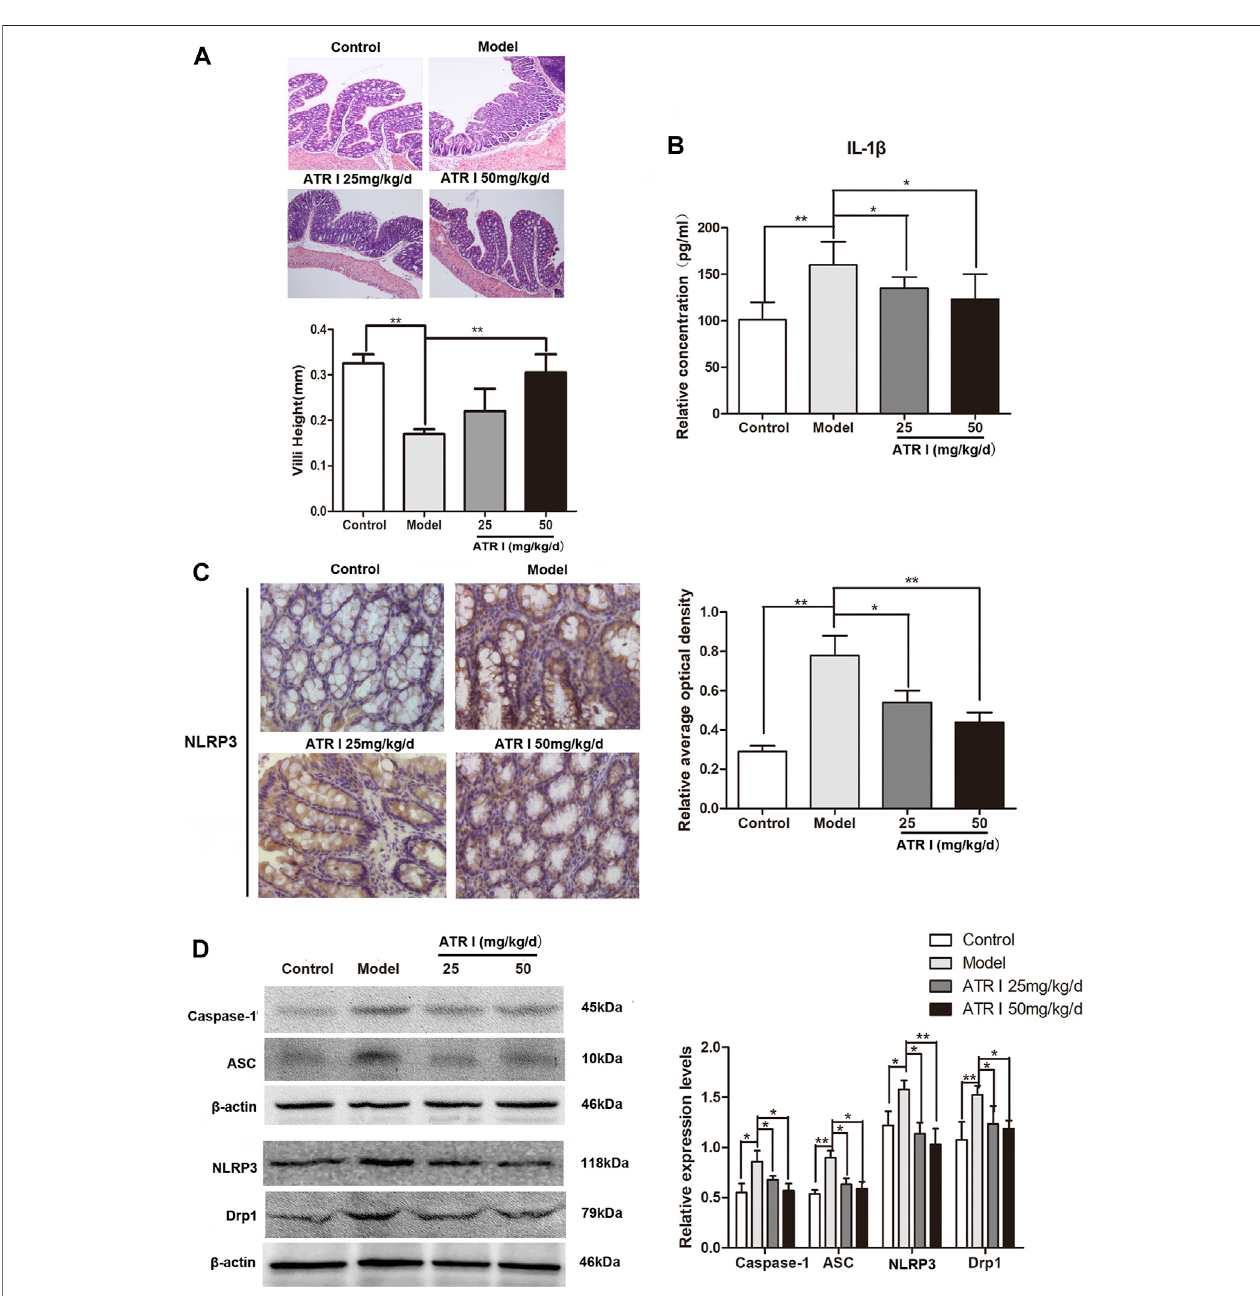
FIGURE 4 | Atractylenolide I inhibited NLRP3 in fl ammasome formation and activation induced IL-1 β secretion. (A) Histological study based on hematoxylin and eosin (H&E) staining, scale bar (cid:2) 200 μ m. Villi height was measured. (B) The concentrations of IL-1 β in the serum of mice weremeasured by ELISA. (C) IHC of NLRP3 in colonictissuesection.Positivestainingisbrown. (D) TheexpressionlevelsofNLRP3,caspase-1,ASC,andDrp1intheintestinaltractweredetectedbytheWesternblot analysis (n (cid:2) 3 per group). The densitometric analysis bar diagram of the results: * p < 0.05; ** p < 0.01, vs. model (mean ± S.D).